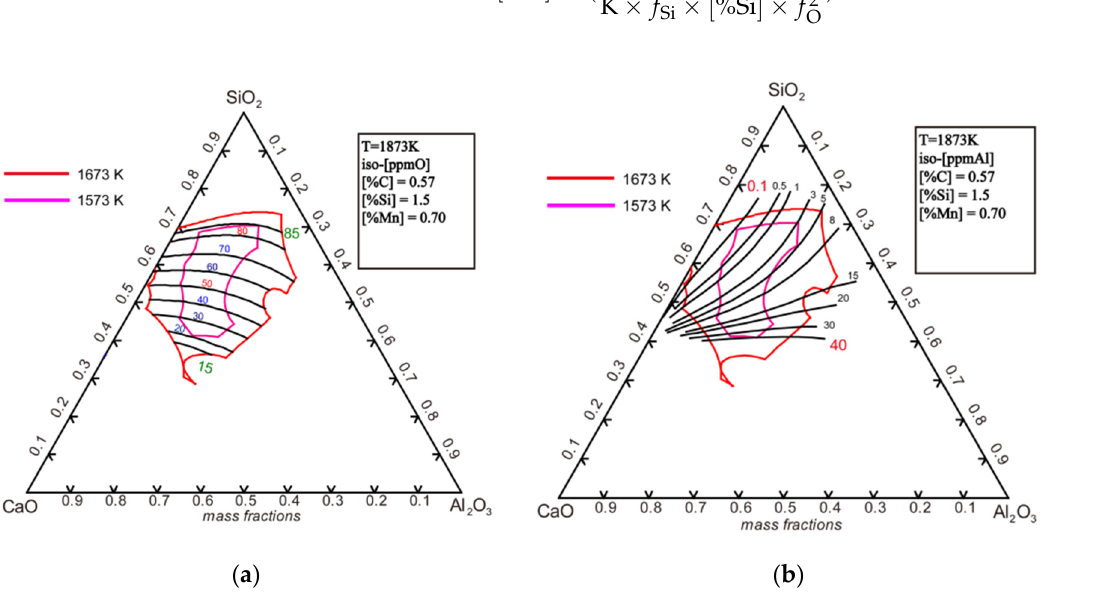
Figure 11. Isoactivity lines of the equilibrium between the molten spring steel 55SiCr and CaO–SiO 2 –Al 2 O 3 –MgO inclusions at 1873 K. (a) Iso-[O] lines and, (b) iso-[Al]. (2) The isoaluminum (Iso-[Al])